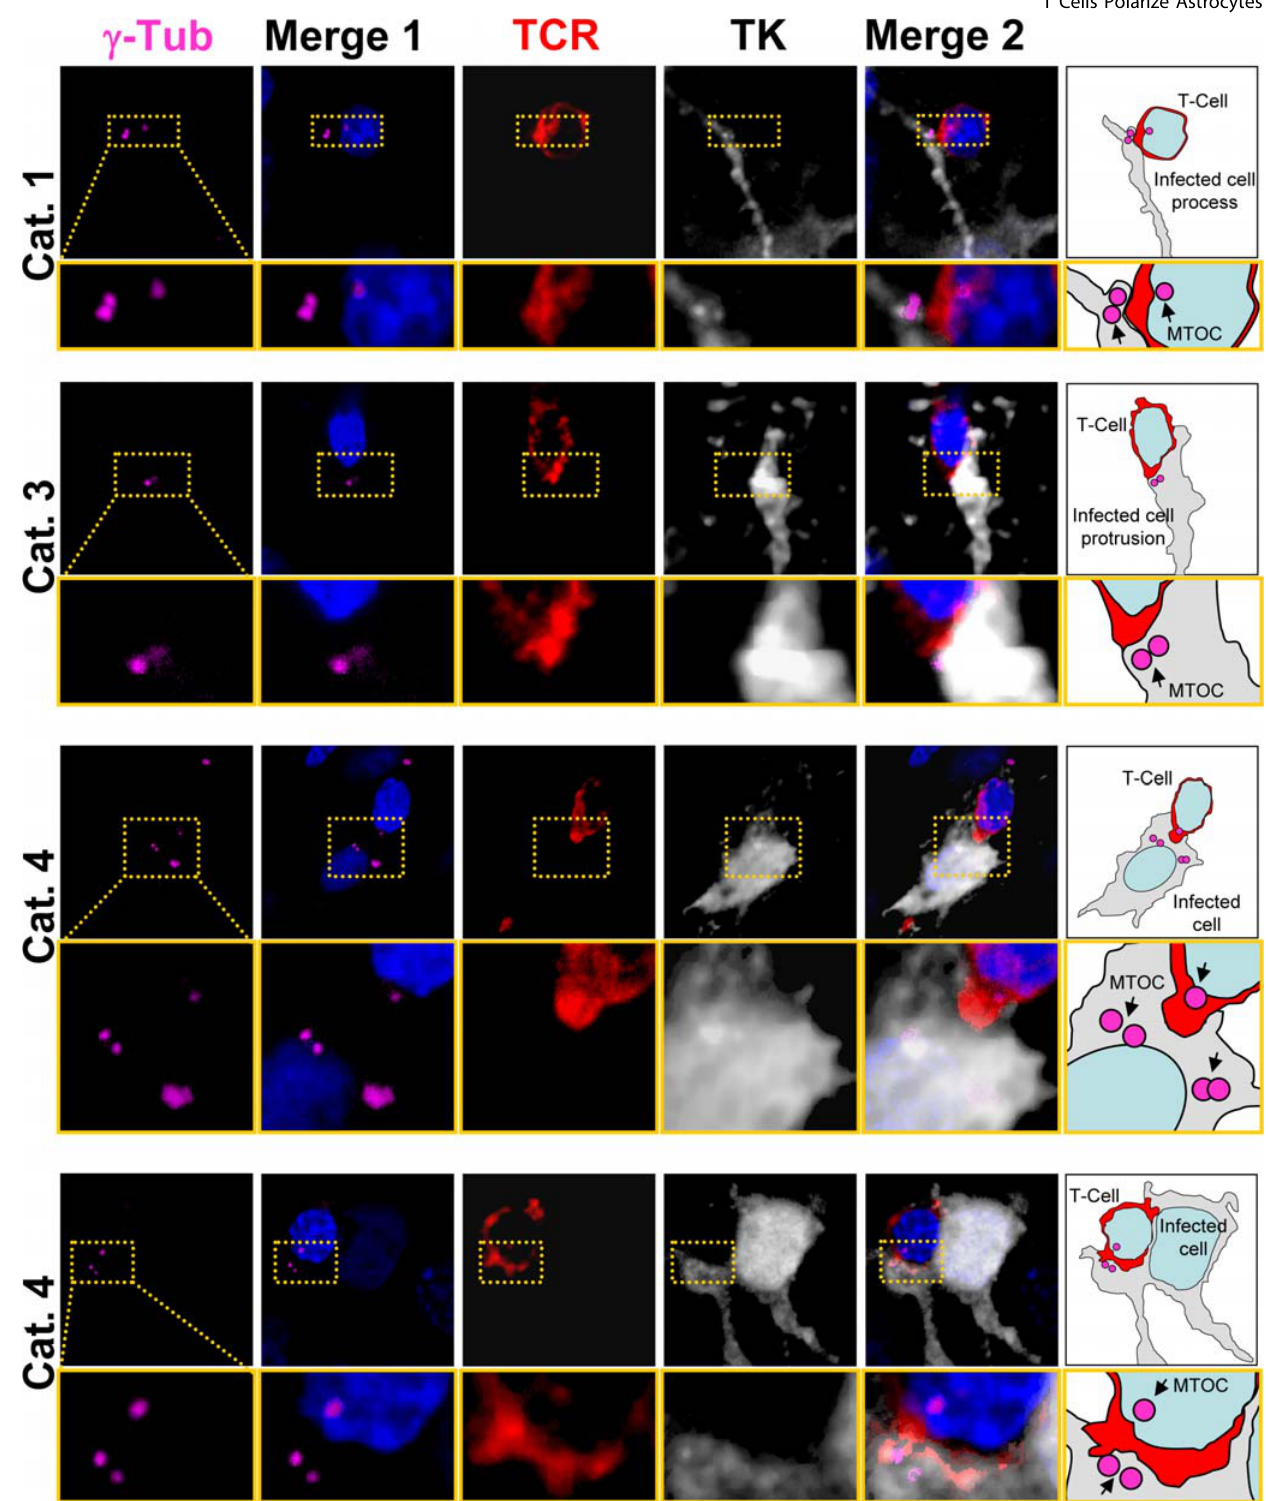
Figure 4. The MTOC of infected brain cells is polarized to the T cell. Representative confocal images of four contacts between astrocytes and T cells. Cells were labeled with markers for MTOC ( c -Tubulin, magenta), viral infection (TK, white), and T cells (TCR, red); and nuclei are stained with DAPI (blue), using immunofluorescent techniques. MERGE 1 is a composite image showing nuclear staining and MTOC. MERGE 2 shows MTOC, virally infected cells, T cells, and nuclei. A magnification of the contact zone is shown below each panel. The right hand column contains drawings of the MERGE 2 images, indicating the spatial relationship between the MTOC (magenta) of the virally infected cells (grey), and the T cells (red). The first row shows a cell of Category 1. The MTOC is localized in a process of the infected cell. The MTOC of the T cell is facing the MTOC of the infected cell. TCR also is polarized towards the infected process. The second row of images represents a cell of Category 3, with MTOC and TCR polarized towards the T cell. The third row shows a cell of Category 4, also with MTOC polarized to the T cell but positioned to one side of the T-astrocyte interface; notice that this astrocyte appears to have multiple MTOC-like structures. Also the MTOC of the T cell is polarized to the MTOC of the infected cell. The bottom row shows another Category 4 cell immunological synaptic junction. doi:10.1371/journal.pone.0002977.g004 PLoS ONE |